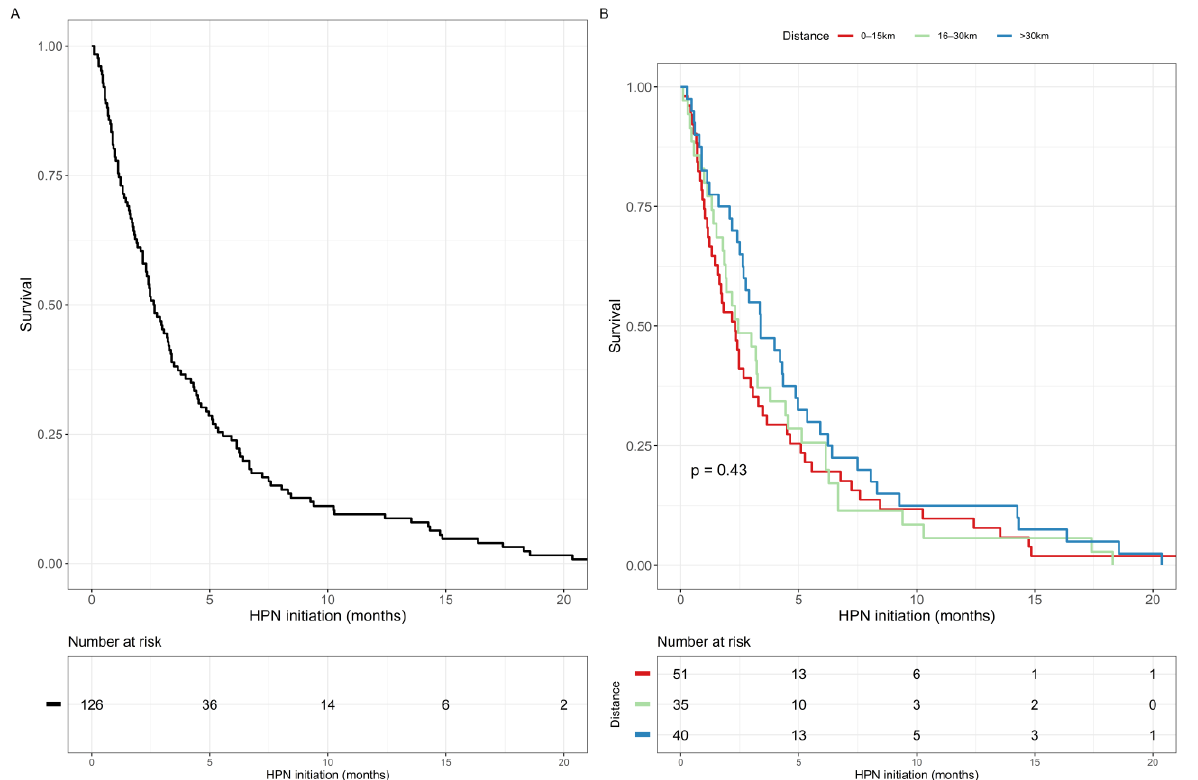
Figure 2. Survival curve for the patient cohort. ( A ) Overall survival, ( B ) Survival stratified by the distance from the patient’s home to the IF center.